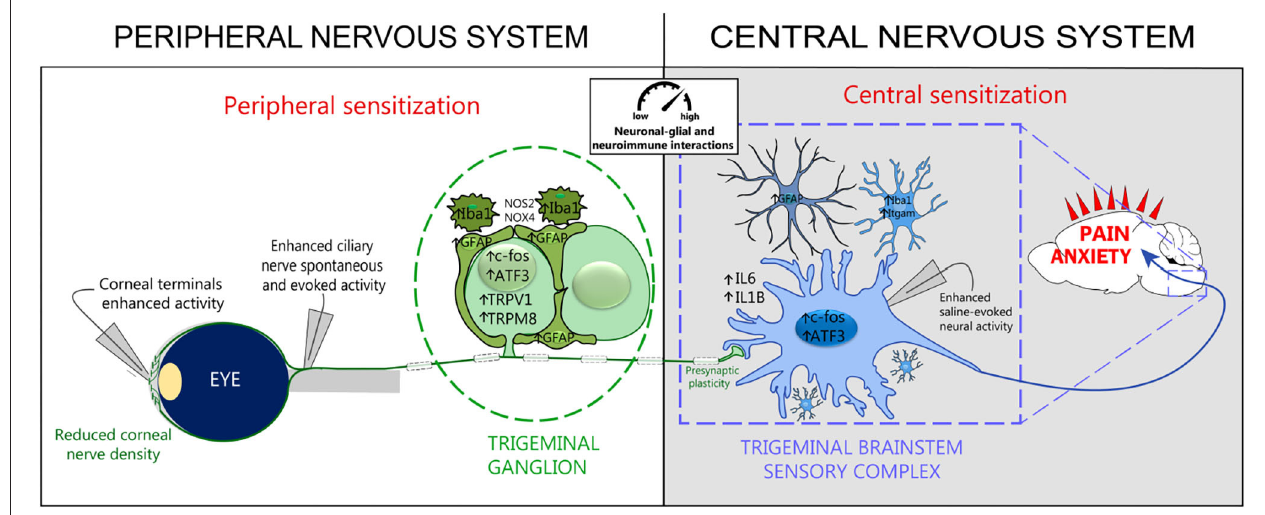
FIGURE 4 | Peripheral and central sensitization associated with persistent dry eye pain. Experimental persistent dry eye triggers corneal nerve abnormalities, neuroimmune interactions, and peripheral and central sensitization. Electrophysiological recordings reveal increased activity in corneal terminals, ciliary nerves, and trigeminal brainstem sensory complex neurons. Histological and molecular studies show neuronal activation (c-Fos) and injury (ATF3), de novo channel production (TRPV1, TRPM8), glial activation (Iba1, GFAP, Itgam), oxidative stress (NOS2, NOX4), proinflammatory responses (IL6, IL1B), and synaptic-enhancer plasticity at the level of TG and TBSC. These cellular and molecular changes lead to pain and promote anxiety-like behaviors. Modified from Guerrero-Moreno et al.